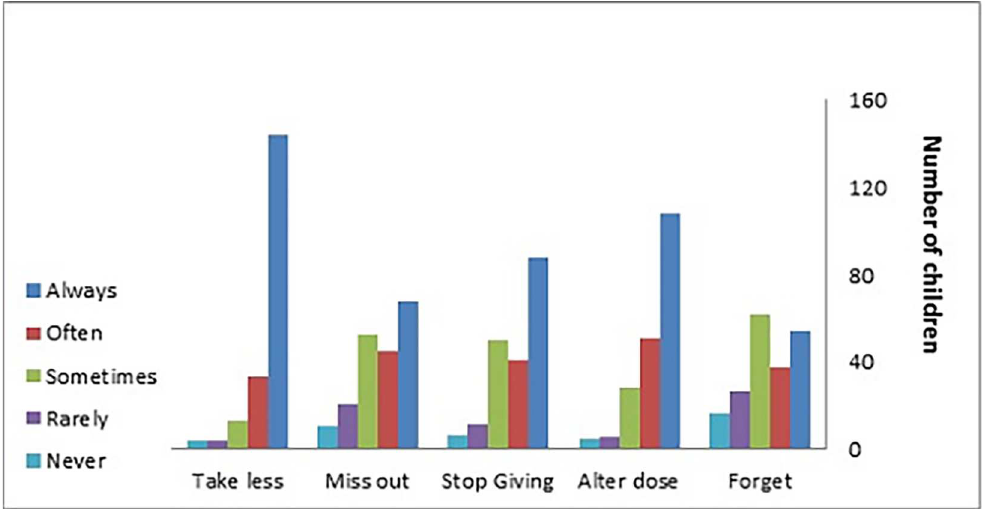
Fig 4. Child reported adherence to their medication [n =